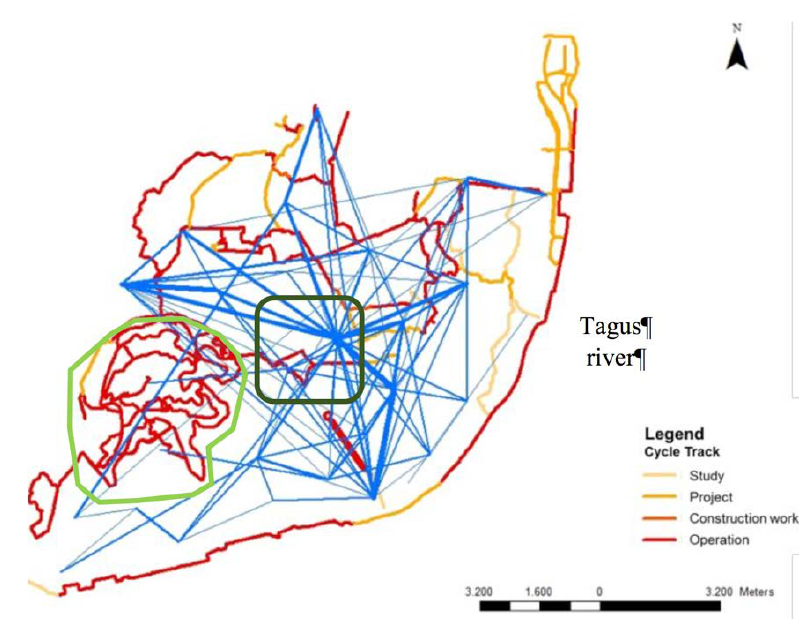
Figure 2. Demand desire lines and today’s cycle